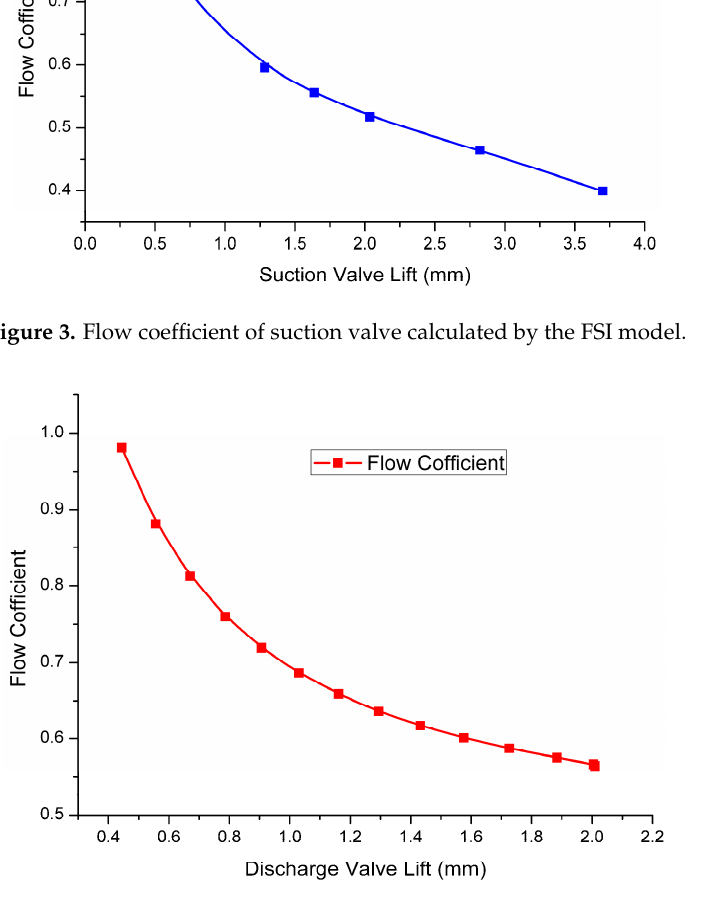
Figure 4. Flow coefficient of discharge valve calculated by the FSI model.